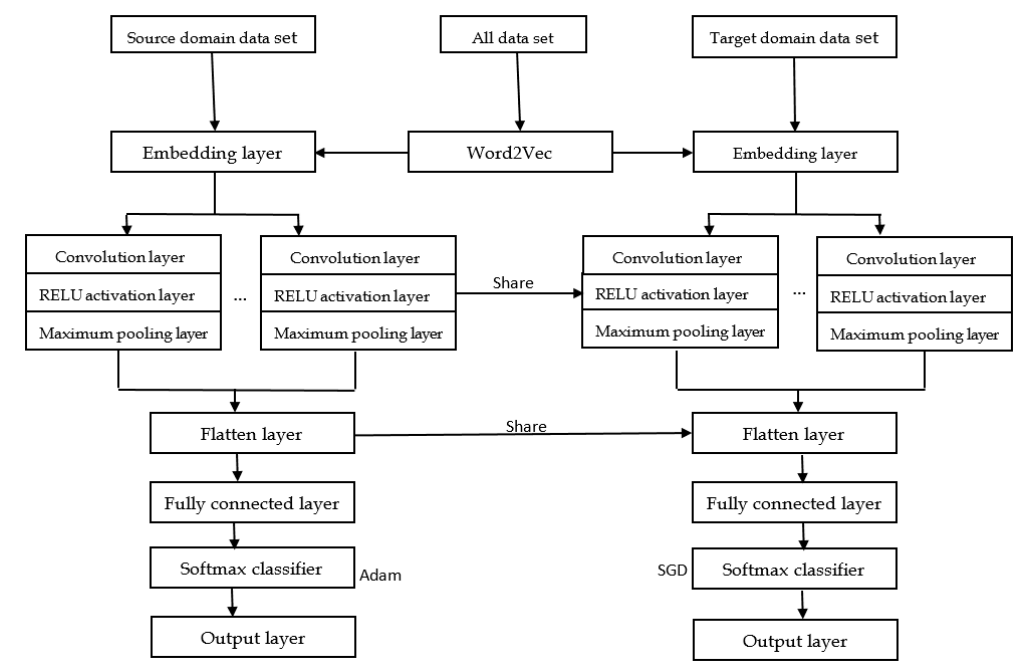
Figure 2. Framework of CNN-based transfer model.